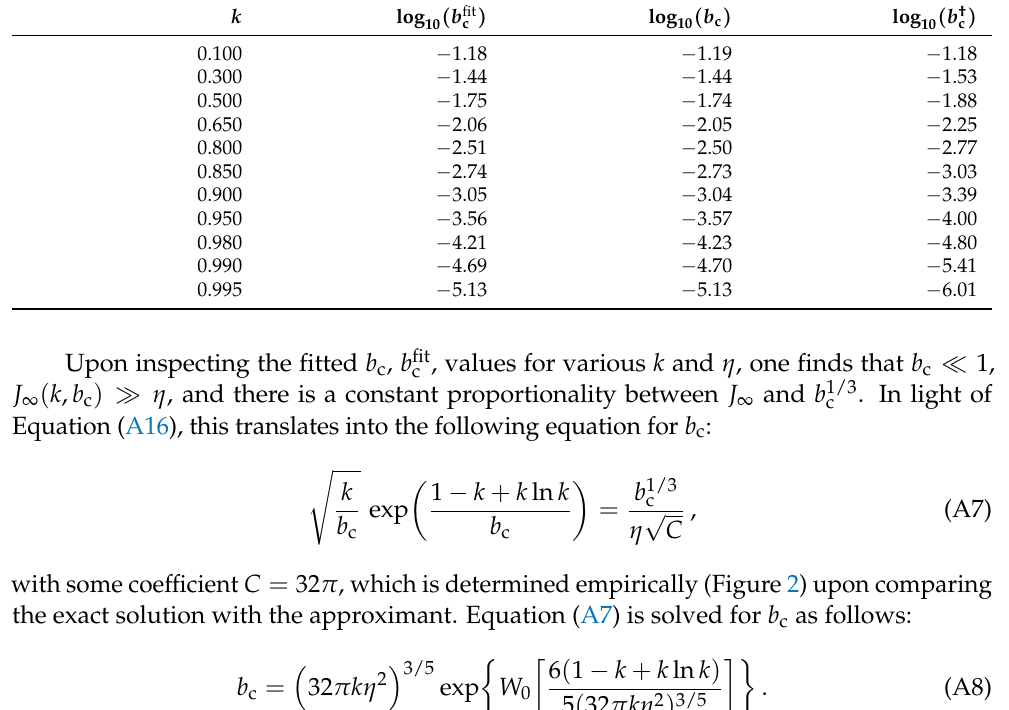
Table A1. Critical value b c of the reduced vaccination rate b to be used in the interpolants (101) and (103). Mentioned for comparison are: the best fitted value b fit c , the analytic expression (92) for b c that is used throughout this paper and the rough estimate b † c according to Equation (A6). The value η = 10 − 6 is used for this table; the analytic expression (92) works equally well for any η (cid:28) 1. ( b c ( b fit ) log k log c 10 10